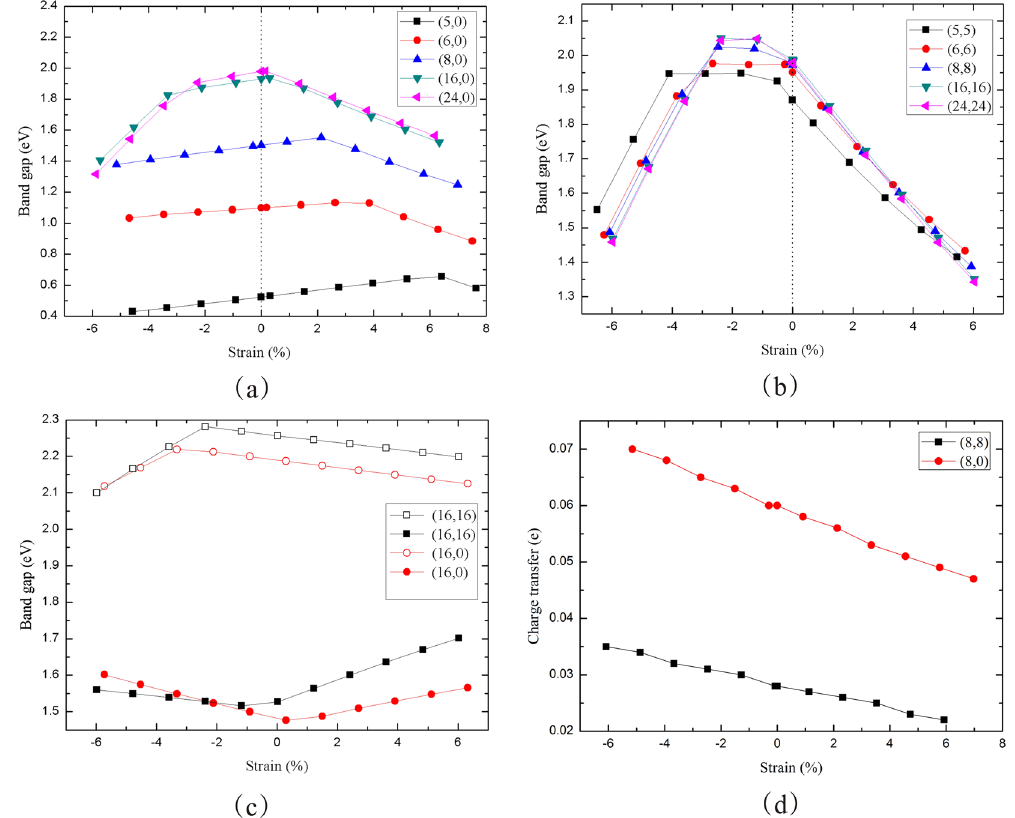
Figure 8. ( a ) Band gap of zigzag blue PNTs versus strain. ( b ) Band gap of armchair blue PNTs versus strain. ( c ) Variations of energy eigenvalues of the CBM and VBM as functions of the strain. ( d ) Charge transfer of two types of blue PNTs versus strain.